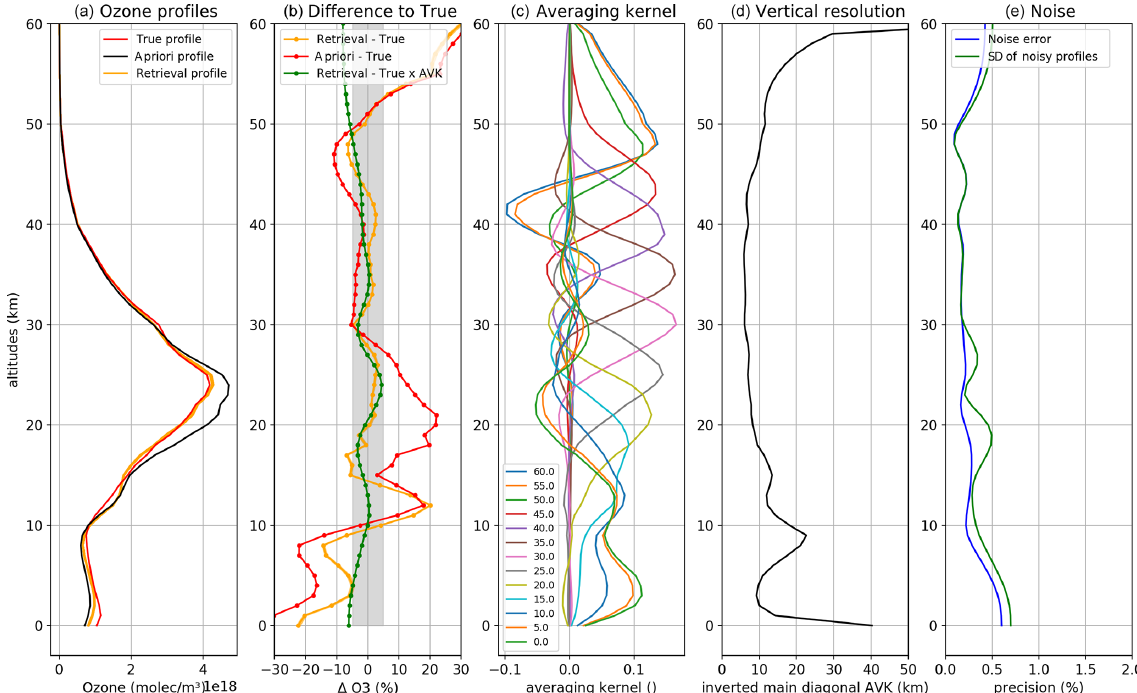
Figure 3. Retrieval diagnostics for the European background profile, SZA of 30 ◦ , VA of 0 ◦ , RAZ of 0 ◦ , and albedo of 0.1. (a, b) Profiles and relative mean differences for 50 noisy spectra. (c) Averaging kernels for every 5km altitude levels. (d) Vertical resolution of the retrieval. (e) Retrieval noise error (blue) as defined by Rodgers (2002) and the standard deviation of the retrieval results from simulated spectra with 50 noise realisations